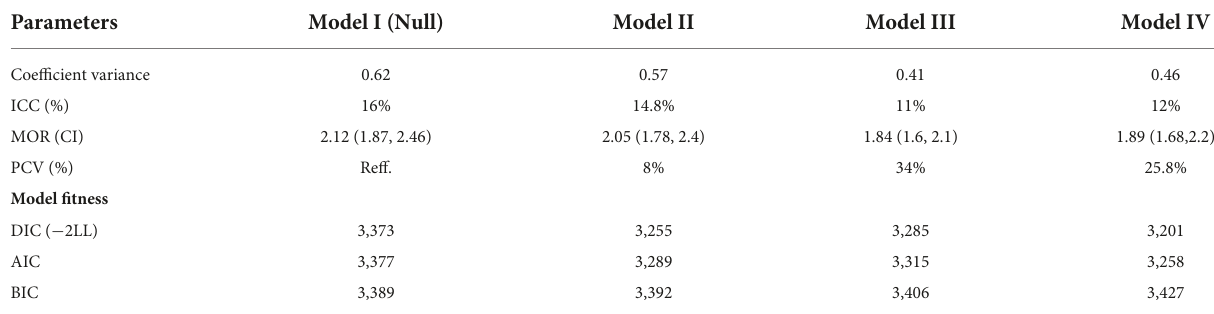
TABLE 4 Random effect and model fit statistics for thinness among late adolescent girls in Ethiopia by multilevel logistic regression analysis, EDHS 2016.